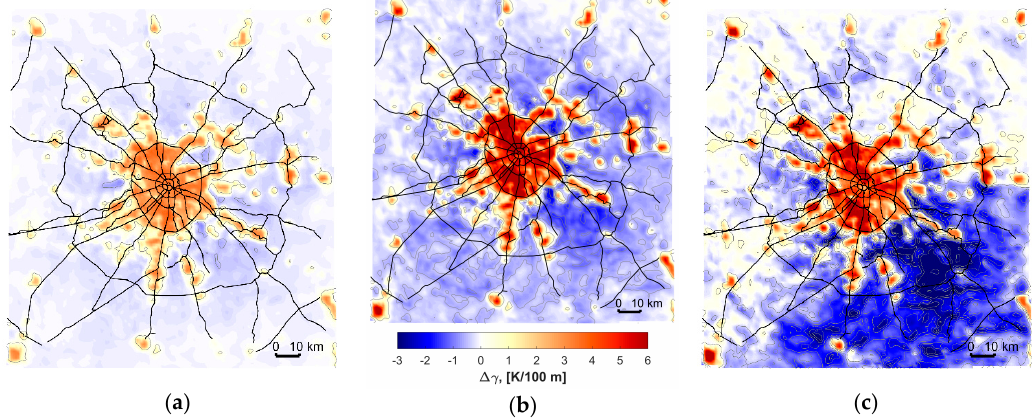
Figure 7. The modeled lapse rate (calculated between two lowest model levels) response to switching on the urban canopy model ( ∆ γ ) for: daily-mean values ( a ); mean nocturnal (0–1 UTC/3–4 MSK) values ( b ); and mean values over nocturnal cases with prevailing northern wind ( c ). Considered cases are sampled out of selection of days with intensive urban heat island during June–August 2014. Black lines represent primary road network.